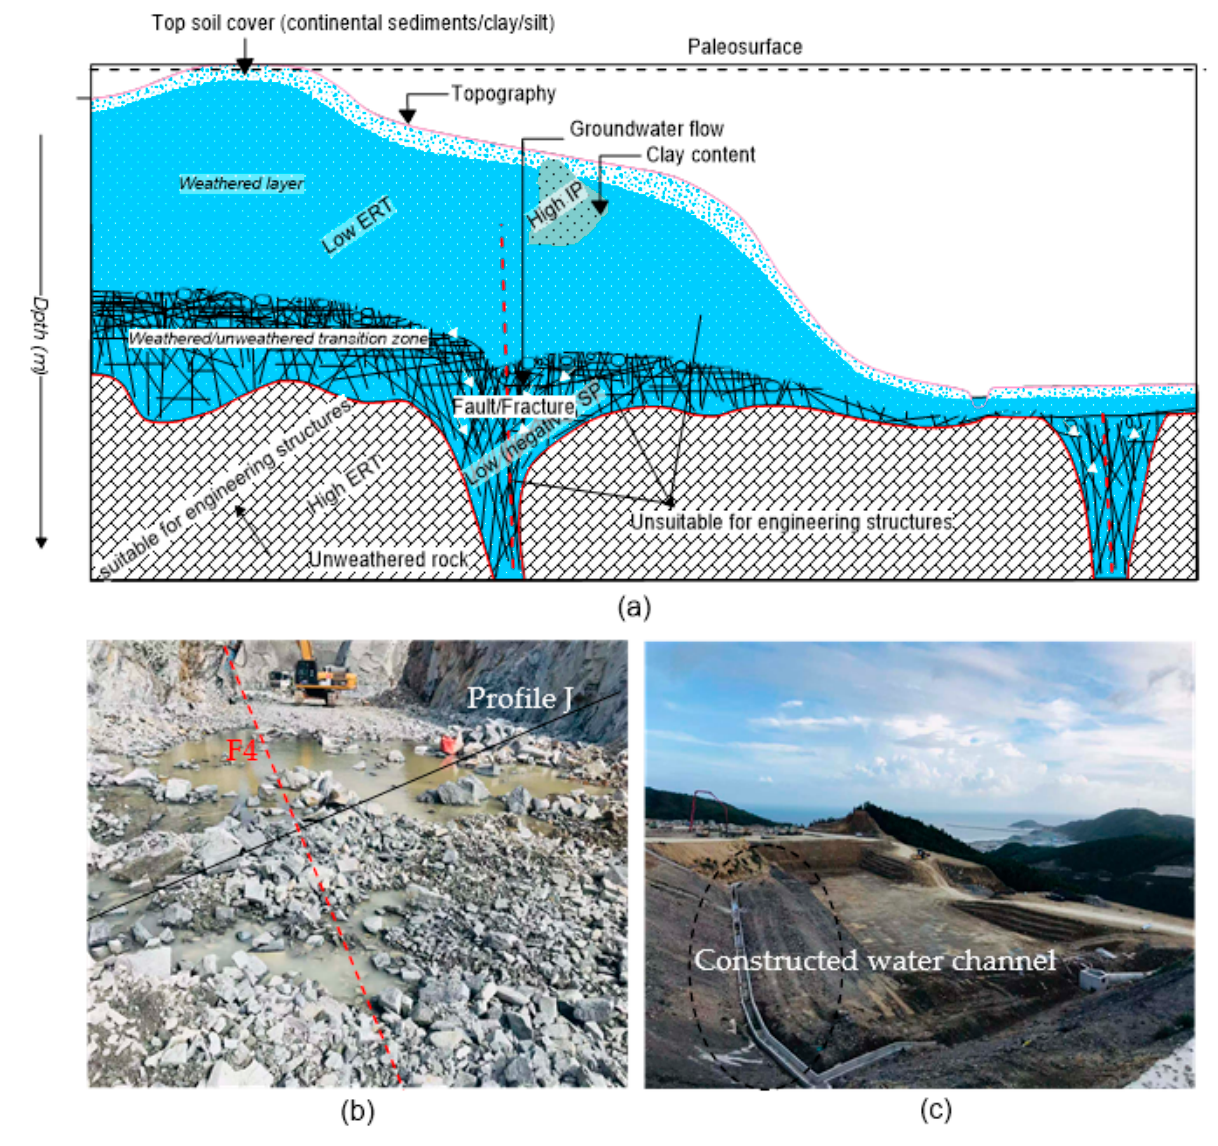
Figure 7. ( a ) A four layered-conceptual model of the investigated area obtained using three geophysical methods (ERT, IP and SP) for the delineation of subsurface layers, fractures/faults, clay and groundwater flow, ( b ) Water seepage during the construction as identified by the interpreted fault F4 along profile J, and ( c ) A change in construction design was made by constructing a water channel for water infiltration from the identified faults/fractures on southwest side of the project site.